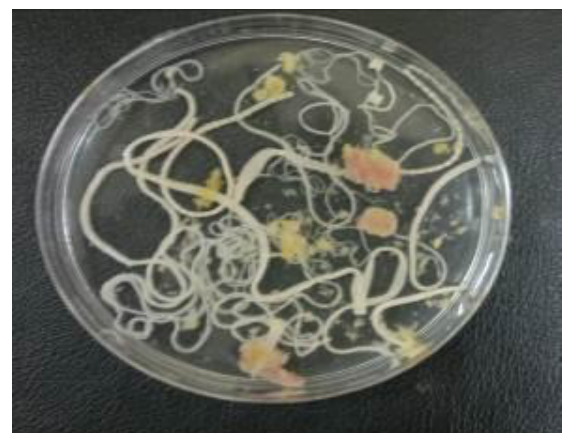
Figure, 2: The parasitic burden of one domestic